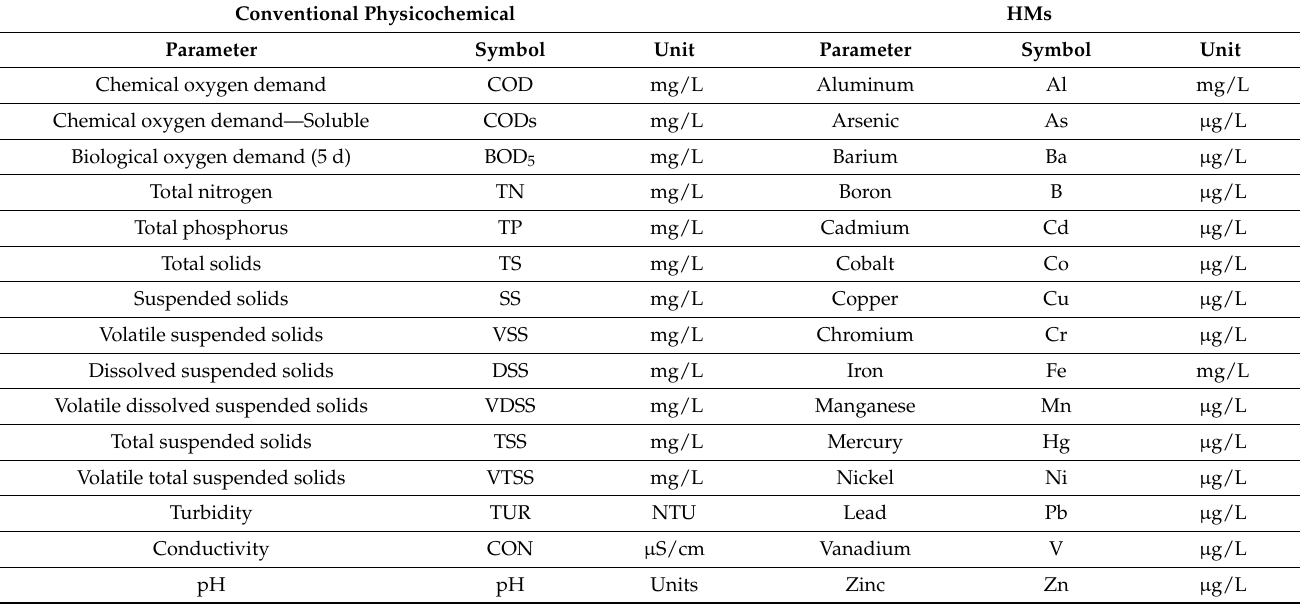
Table 1. Runoff water pollution parameters